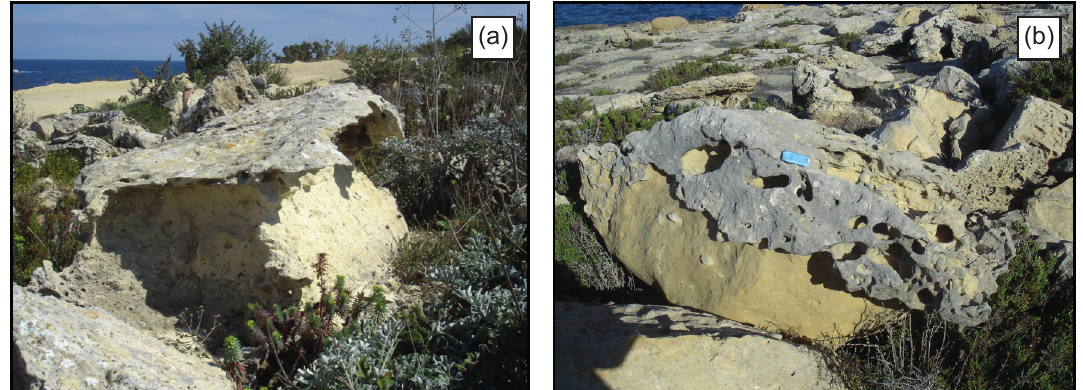
Figure 13. Examples of significant weathering features in the high boulder fields: ( a ) severely weathered boulder with an indurated surface forming a carapace undercut by face weathering to a depth of 170 mm; ( b ) a further form of weathering in which the indurated surface of a large boulder has been widely undermined by the formation of tafoni and their lateral development (the scale object is 70 mm in